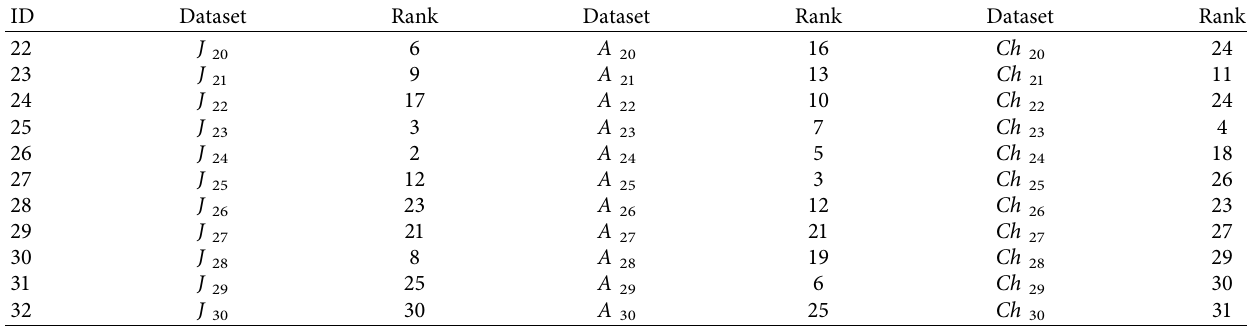
Table 9: The performance of CNN and other four models on J